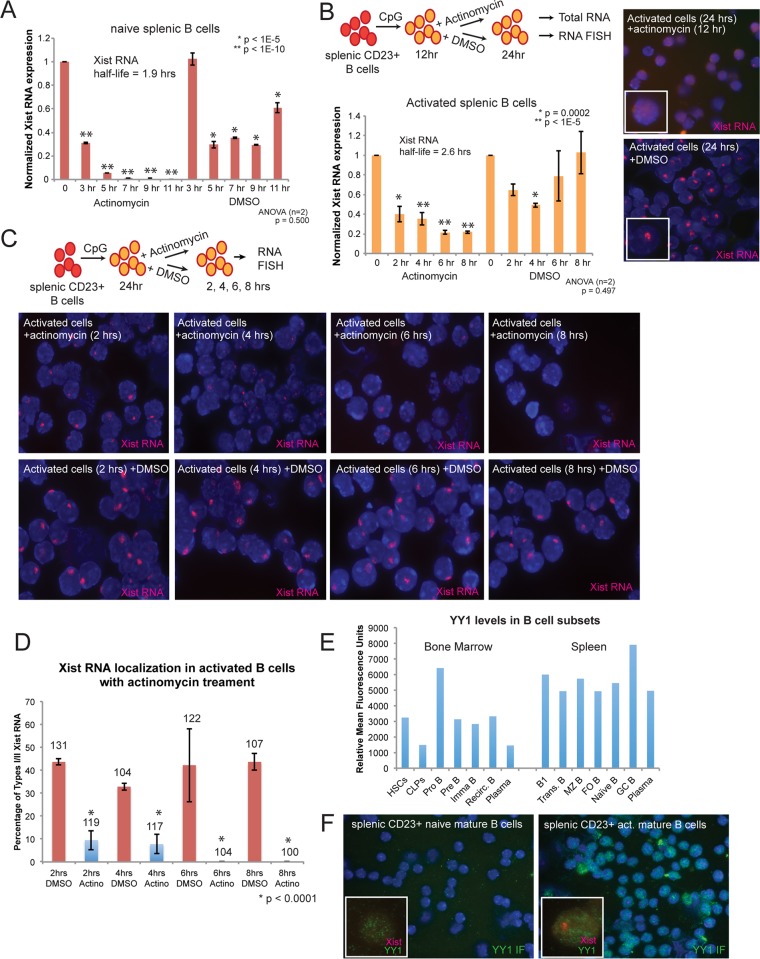
Xist is continuously transcribed in naïve and activated B cells, and YY1 is ubiquitous in all B cell subsets.(A) Xist RNA half-life measurement of naïve splenic B cells using actinomycin D or DMSO control. Xist RNA levels were normalized to the amount of transcript detected at time 0. Half-life is the amount of time for 50% of detectable Xist transcripts at time 0 to remain. Experiments were performed in duplicate, and cycling reactions in triplicate. Error bars denote standard deviations from the mean for technical replicates within one experiment. Statistical significance to test for reproducibility between independent replicate experiments was determined using ANOVA, and p values confirmed similar results. (B) Schematic for the experimental design to calculate Xist RNA half-life in activated splenocytes. Splenic B cells were stimulated with CpG for 12 hours, then treated with actinomycin D or DMSO control for another 12 hrs. Xist RNA half-life measurement of stimulated splenic B cells using actinomycin D, or DMSO control. Representative Xist RNA FISH images of activated splenic B cells after 12 hrs actinomycin treatment (or DMSO control). Error bars denote standard deviations from the mean for technical replicates within one experiment. Statistical significance to test for reproducibility between independent replicate experiments was determined using ANOVA, and p values confirmed similar results. (C) Schematic for time course experiments to examine Xist RNA localization following actinomycin treatment in activated B cells. Splenic B cells were stimulated with CpG for 24 hrs, then treated with actinomycin D or DMSO control for another 8 hrs, and cells were harvested every 2 hrs for Xist RNA FISH. Representative Xist RNA FISH images for activated B cells after 2, 4, 6, or 8 hrs of actinomycin treatment (or DMSO control). (D) Quantification of Type I/II Xist RNA localization patterns for actinomycin D and DMSO (control) treated cells. The average from two independent experiments is shown; error bars denote standard deviation from the mean between independent experiments. Statistical significance was determined using Chi-squared tests. The total number of nuclei counted is shown above each column. (E) Relative mean fluorescence intensity for YY1 protein in sorted B cell subsets (See Supplemental Experimental Procedures for cell surface markers). (F) Sequential Xist RNA FISH (red) and YY1 immunofluorescence (green) in naïve and CpG stimulated splenic B cells.